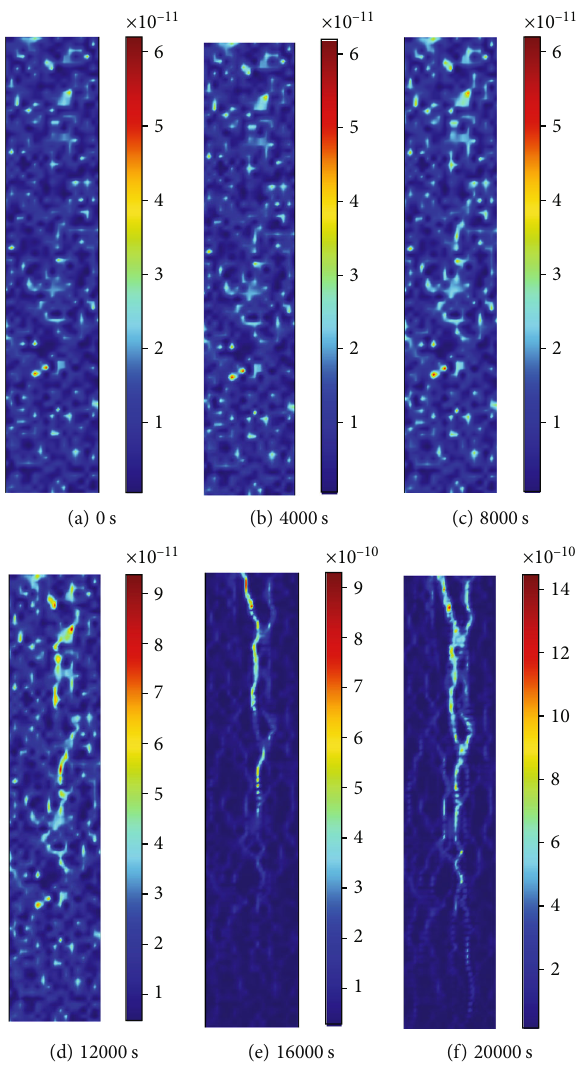
Figure 11: Permeability cloud map